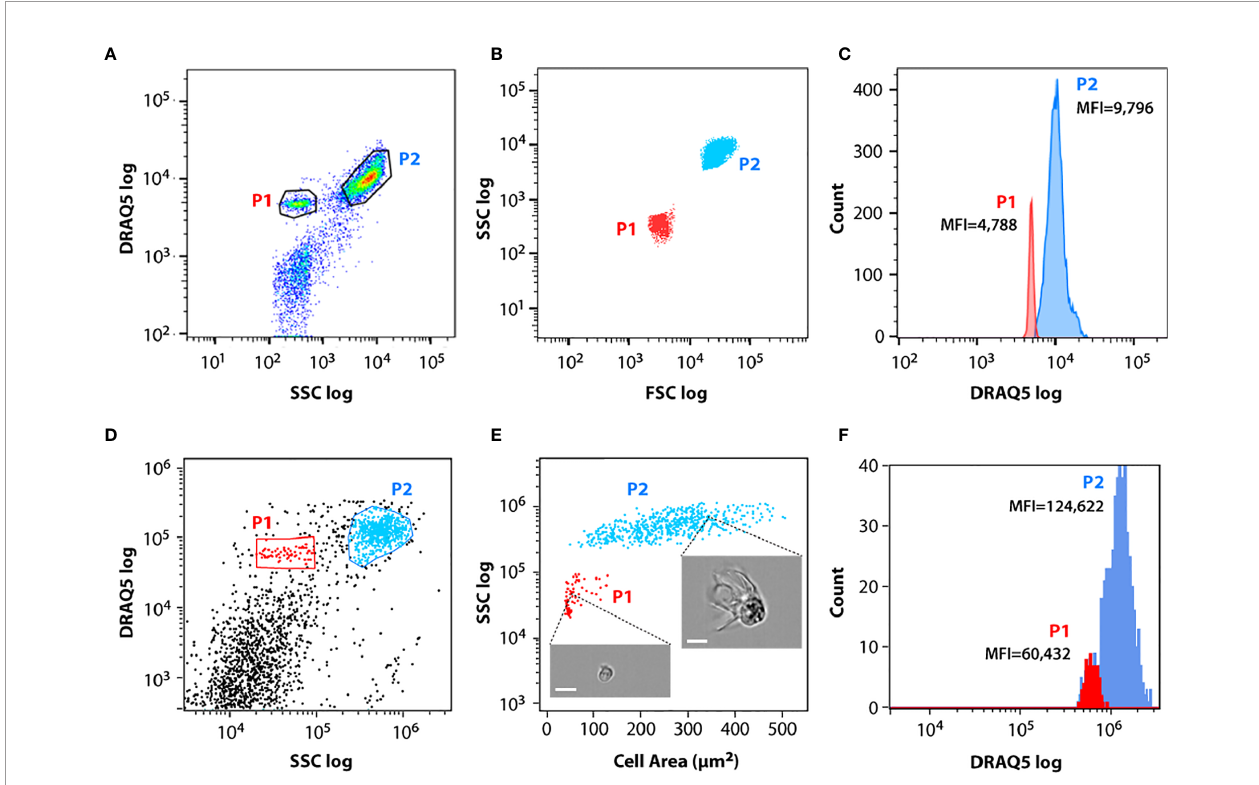
FIGURE 1 | Flow cytometry (FC) and imaging fl ow cytometry (IFC) analysis of circulating coelomocytes. Coelomocytes were stained with DRAQ5. (A) Representative FC dot plot of coelomocytes with cell populations gated. (B) Overlap of FC dot plots showing representative forward and side scatter properties of P1 (red) and P2 (blue) cell populations. (C) Overlap of P1 (red) and P2 (blue) FC cell populations histograms showing their median fl uorescence intensity (MFI) in the DRAQ5 (660/20 BP) channel. (D) Representative IFC dot plot of coelomocytes with cell populations gated. (E) Overlap of IFC dot plots showing representative area and side scatter properties of P1 (red) and P2 (blue) cell populations. Insets show two examples of cells imaged in each population; scale bar: 7 m m. (F) Overlap of P1 (red) and P2 (blue) IFC cell populations histograms showing their median fl uorescence intensity (MFI) in the DRAQ5 (642-745 nm)